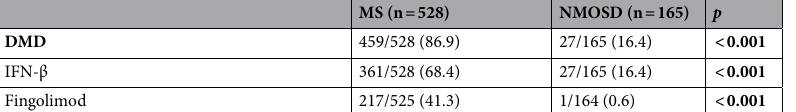
Table 1. Clinical and laboratory characteristics of Japanese patients with MS and NMOSD. Bold values indicate significant differences. Values are median [interquartile ranges] or count (%). Ab , antibody, AID autoimmune disease, ANA , anti-nuclear antibody, AQP4 aquaporin 4, CSF cerebrospinal fluid, EDSS , expanded disability status scale, FS functional system, IFN interferon, IS immunosuppressants, LESCL longitudinally extensive spinal cord lesion, MS multiple sclerosis, MSSS multiple sclerosis severity score, NMOSD neuromyelitis optica spectrum disorders, OCBs oligoclonal IgG bands, PI progression index, PP primary progressive, PSL prednisolone, RR , relapsing–remitting, SP secondary progressive, Tg thyroglobulin, TPO thyroid peroxidase, TSHR thyroid stimulating hormone receptor, y years. *In the section of functional system scores, values are median [10–90th